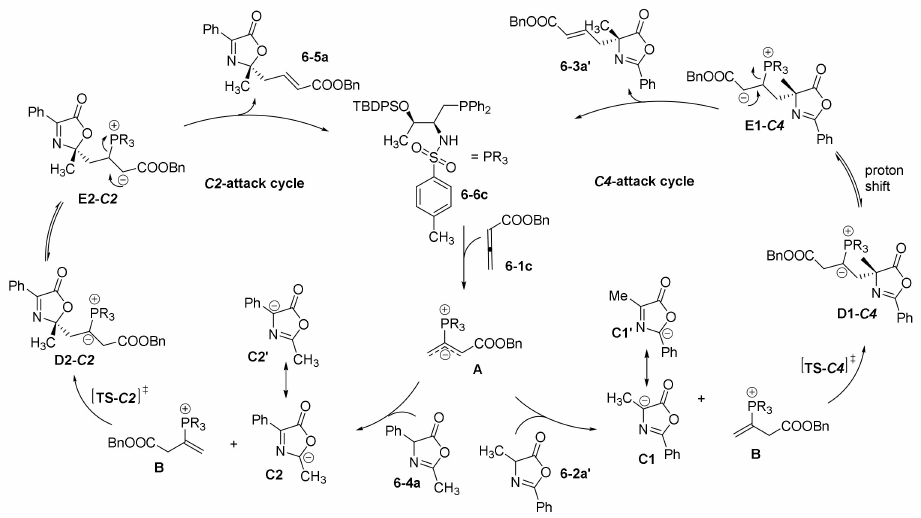
Scheme 13. Proposed mechanism for γ -additions of